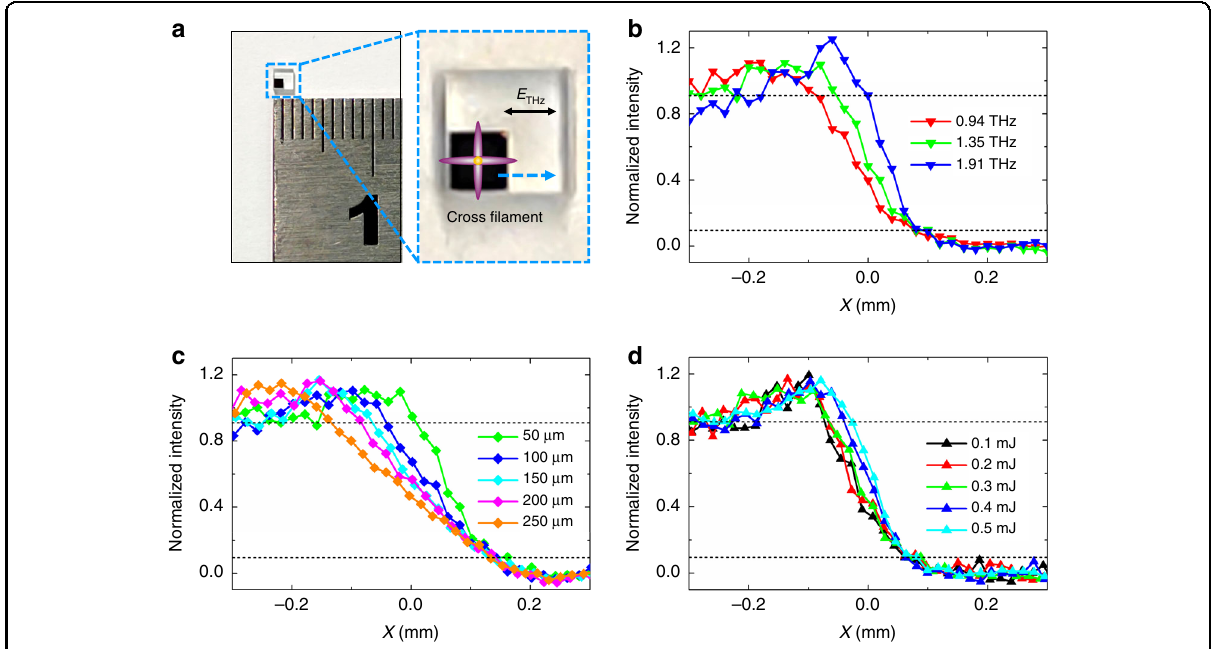
Fig. 3 Resolution estimation. a Sample for the knife-edge method and a ruler. The sample was a 1 mm×1mm Cr fi lm on a glass substrate. The edge of the fi lm was raster scanned along the X direction to evaluate the spatial resolution of the THz near- fi eld microscope. Its magni fi ed view shows the relationships between the Cr fi lm-edge, cross- fi lament, scan direction, and THz polarization. b Normalized resolution curves for various spectral components. c Normalized resolution curves for various heights h between the cross- fi lament and the sample surface. d Normalized resolution curves for various pulse energies of the control